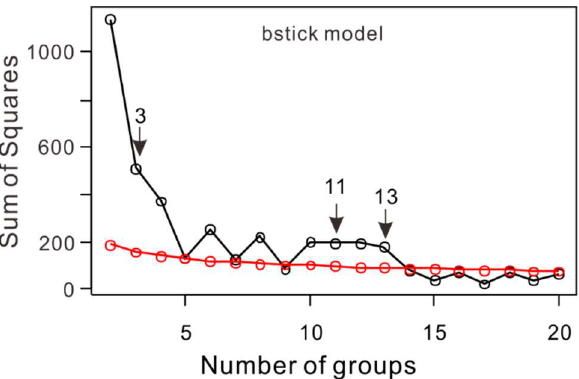
Figure 3. The bstick model illustrating the statistically significant number of chemozones.